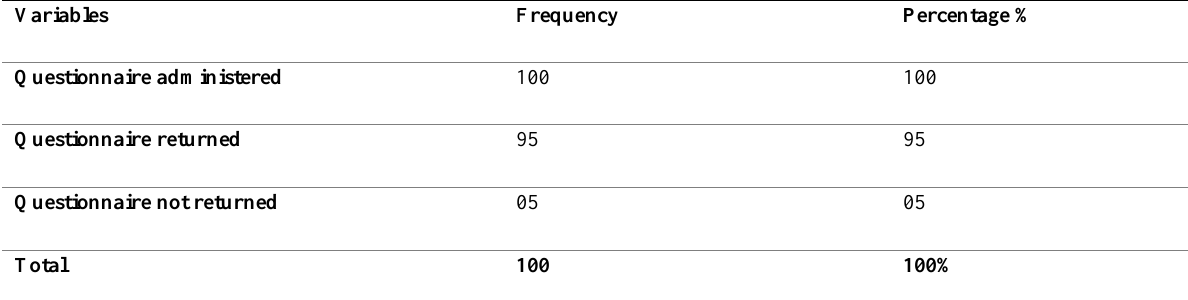
Table 1: Questionnaires Administered to Some Registered SMEs